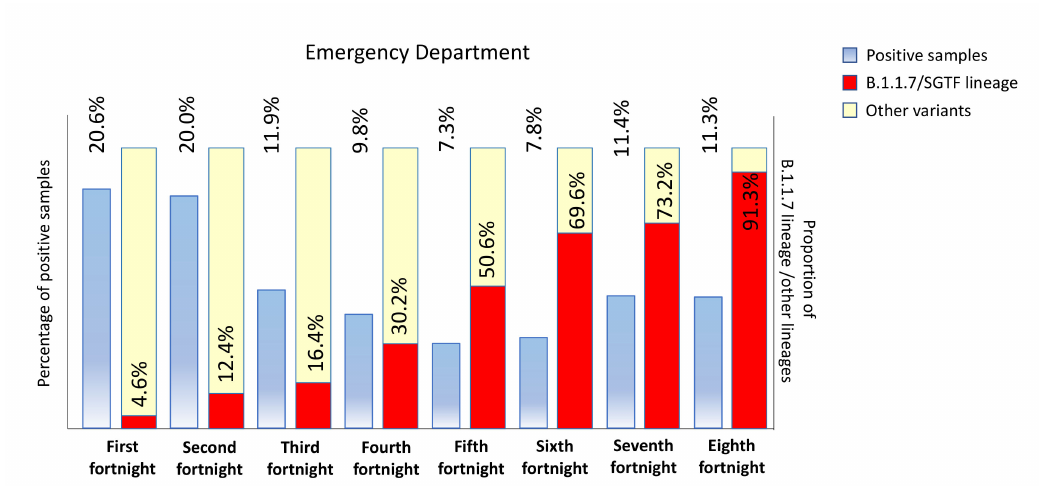
Figure 2. Temporal evolution in the incidence of B.1.1.7 (Alpha variant) in the emergency department from 02 January to 22 April 2021. SGTF: strategy S gene target